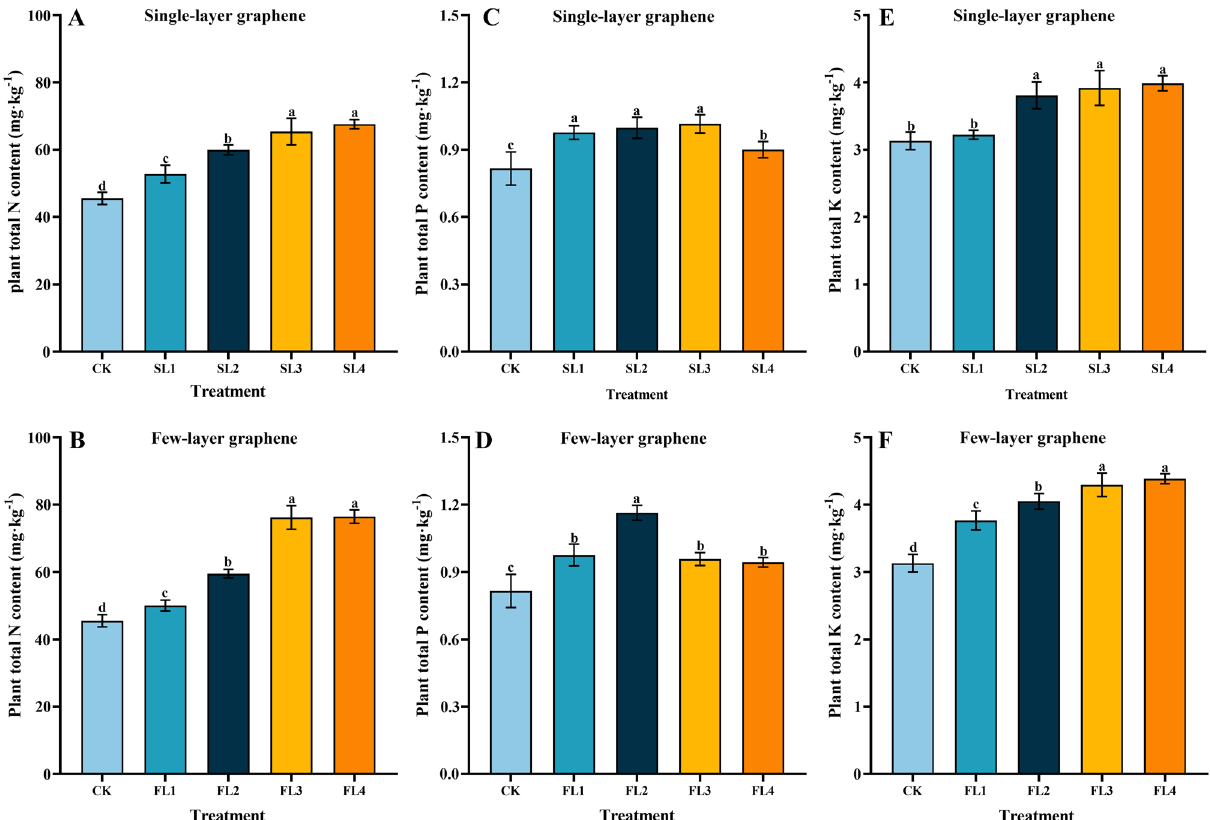
Figure 4. Effect of different graphene concentration and type on plant total N, total P and total K content. CK. 0 g kg −1 single-layer graphene and 0 g kg −1 few-layer graphene; SL1 and FL1. 25 g kg −1 single-layer graphene and 25 g kg −1 few-layer graphene; SL2 and FL2. 50 g kg −1 single-layer graphene and 50 g kg −1 few-layer graphene; SL3 and FL3. 100 g kg −1 single-layer graphene and 100 g kg −1 few-layer graphene; SL4 and FL4. 150 g kg −1 single- layer graphene and 150 g kg −1 few-layer graphene; ( A , C , E ) single-layer treatment; ( B , D , F ) few-layer treatment; error bars indicate ± standard deviation. Different letters above error bars indicate significant difference between treatment ( p < 0.05, LSD test).